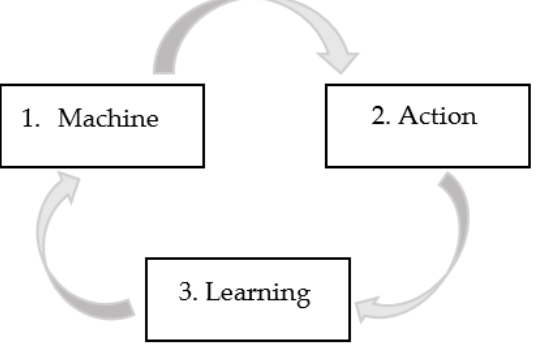
Figure 7. Key components of the project: Learning machines. Source: own study.